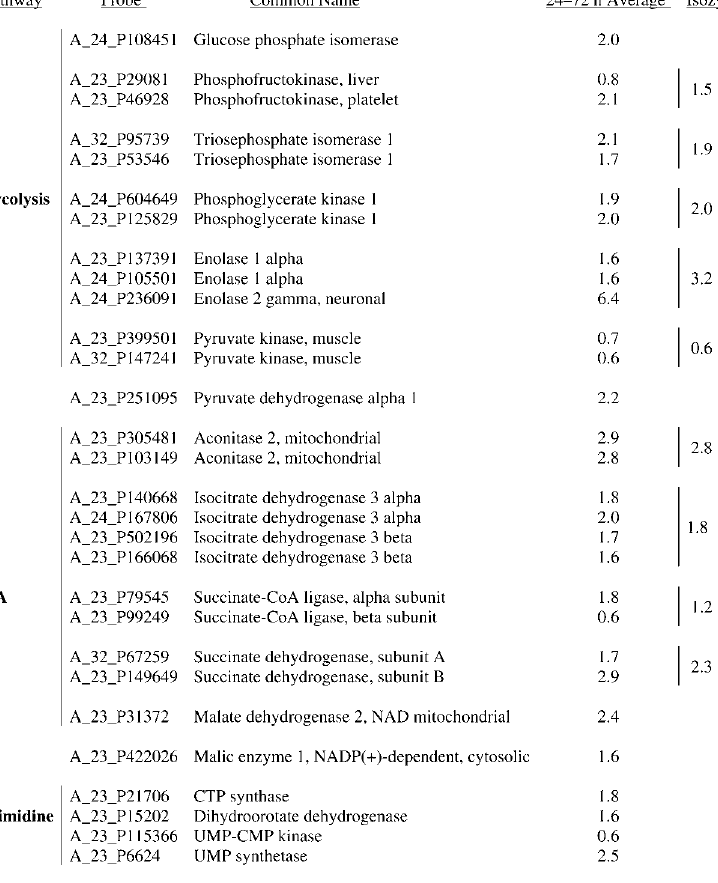
Figure 7. Effect of HCMV on RNA Levels of Glycolytic, TCA Cycle, and Pyrimidine Biosynthetic Enzymes Transcriptional data that passed variance analysis (ANOVA, p , 0.05). a More information on specific genes can be accessed using probe designations at http://www.reactome.org. b Average fold induction over mock infection (averaged over 24, 48, and 72 hpi). c Represents averaged isozyme/subunit induction over mock in cases where data for multiple isozymes/subunits